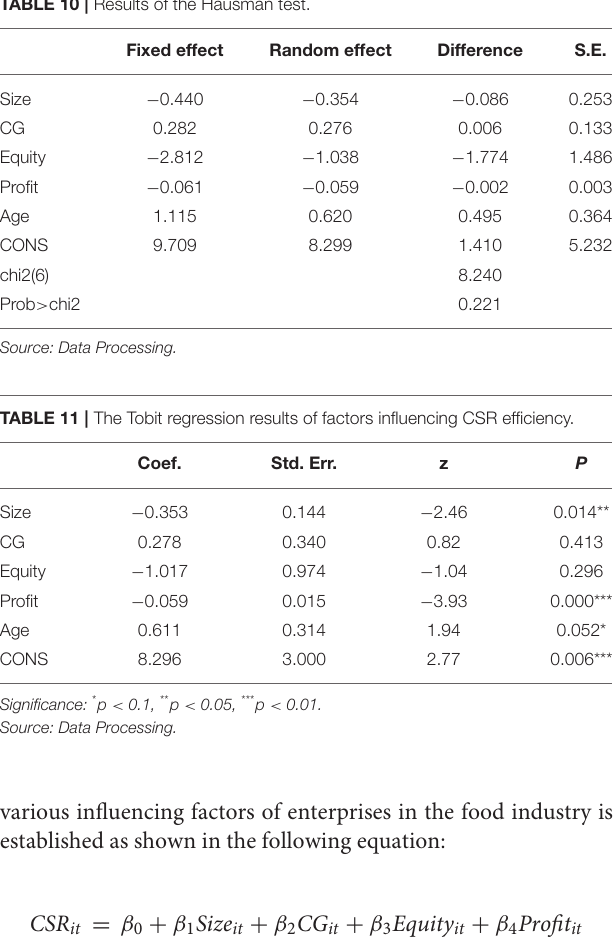
TABLE 10 | Results of the Hausman test.